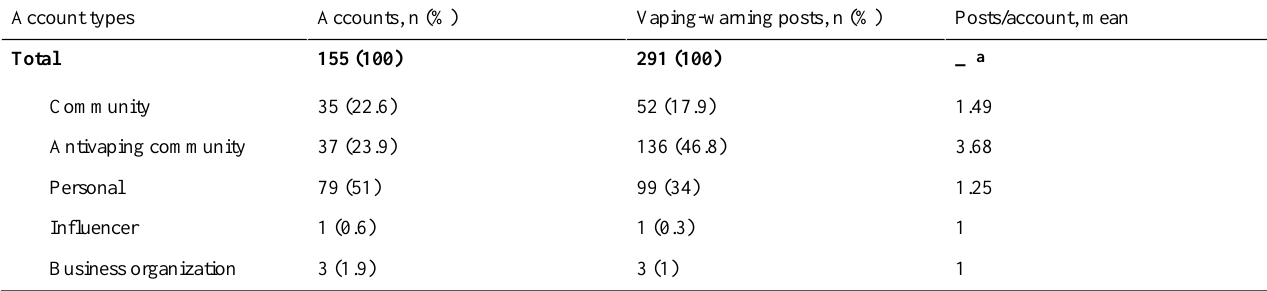
Table 3. The account types of the vaping-warning Instagram user